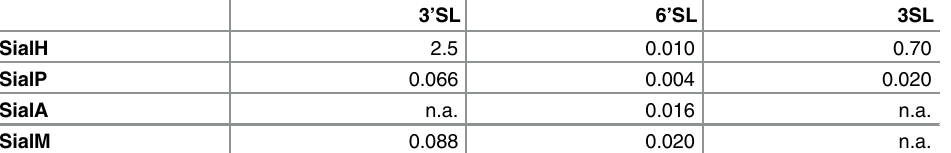
Table 4. Best product-to-hydrolysis ratio (R P,H ) for the four candidates calculated for each trans-sialy- lation